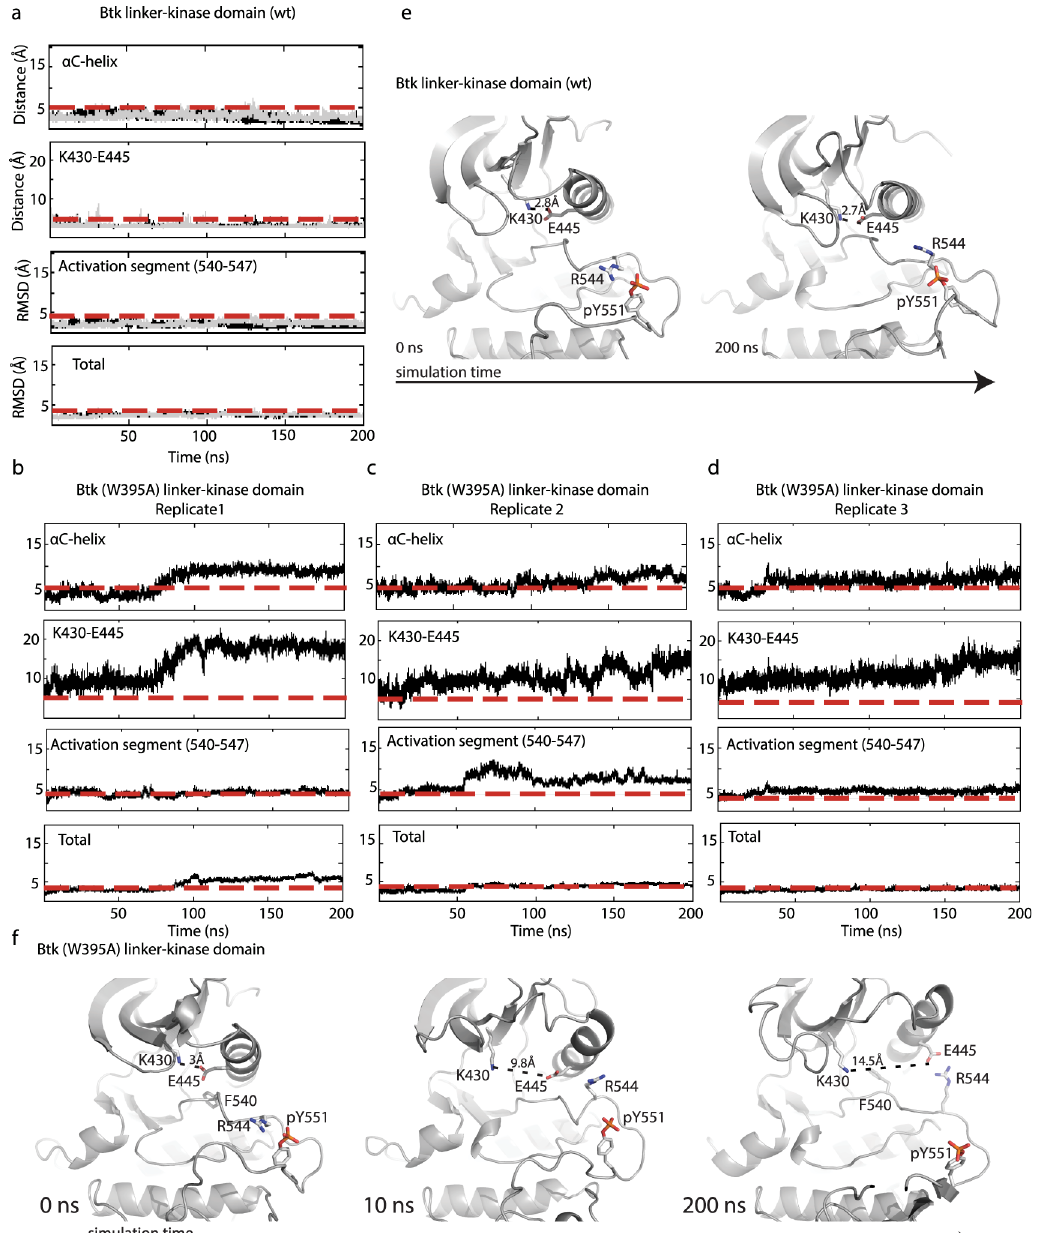
Fig 3. MD simulations of Btk linker-kinase and Btk (W395A) linker-kinase domains. Two replicate (200 nanosecond (ns) each) equilibrium simulations (black/light grey traces) are shown for Btk linker-kinase ((a), superimposed) and three 200 ns replicates of (W395A) linker-kinase domain are shown in (b,c, d). RMSD from the starting structure is reported for the backbone atoms (total), activation segment (540 – 547) and α C-helix (439 – 451). The distance ( Å ) between the side-chains of K430 and E445 is shown over the course of the simulations. The red dashed lines in each plot are included for ease of comparison between mutant and wild type trajectories. (e,f) Snapshots of structures from the wild type Btk linker-kinase simulation at 0 and 200 ns (e) and from the Btk (W395A) linker-kinase simulation at 0, 10 and 200 ns (f). The wild type Btk linker-kinase domain retains the active conformation throughout the 200 ns simulation. The K430/E445 salt bridge distance is indicated and the interaction between R544 and pY551 is evident at the beginning and end of the simulation. Btk (W395A) linker-kinase domain starts in the active conformation but moves toward the inactive state as early as 10 ns. Further transition to the inactive conformation ( ‘ C-out ’ ) is observed as the simulation progresses and at 200 ns the K430/E445 distance is 14.5 Å and R544 contacts the side chain of E445 rather than pY551. F540 is shown at 0 and 200 ns in the Btk (W395A) linker-kinase structures to illustrate the shift from the active DFG conformation to